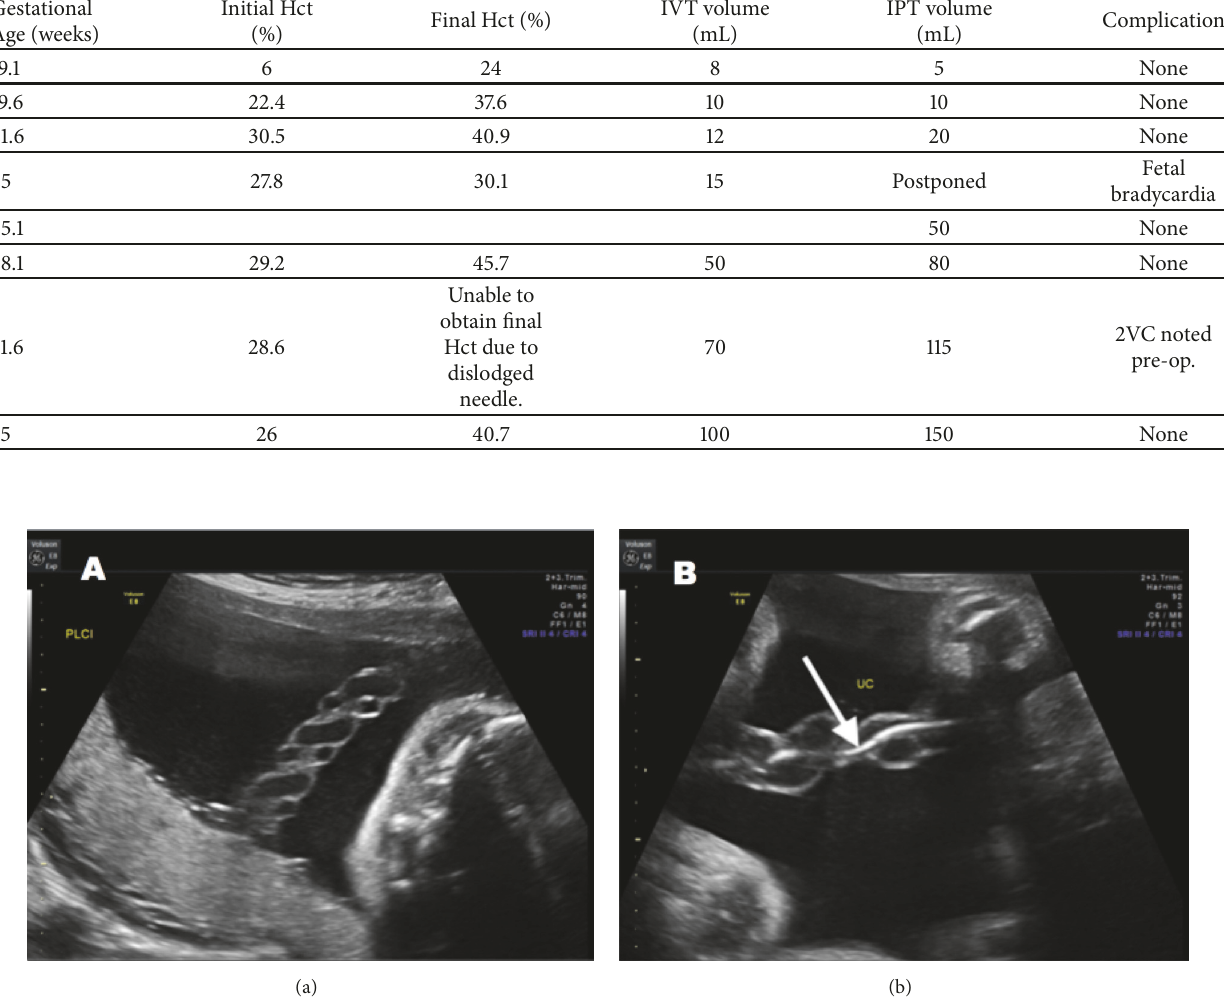
Figure 1: (a) Three-vessel cord with two patent umbilical arteries was noted on initial evaluation. (b) Thrombosed umbilical artery (arrow) is seen in this segment of the